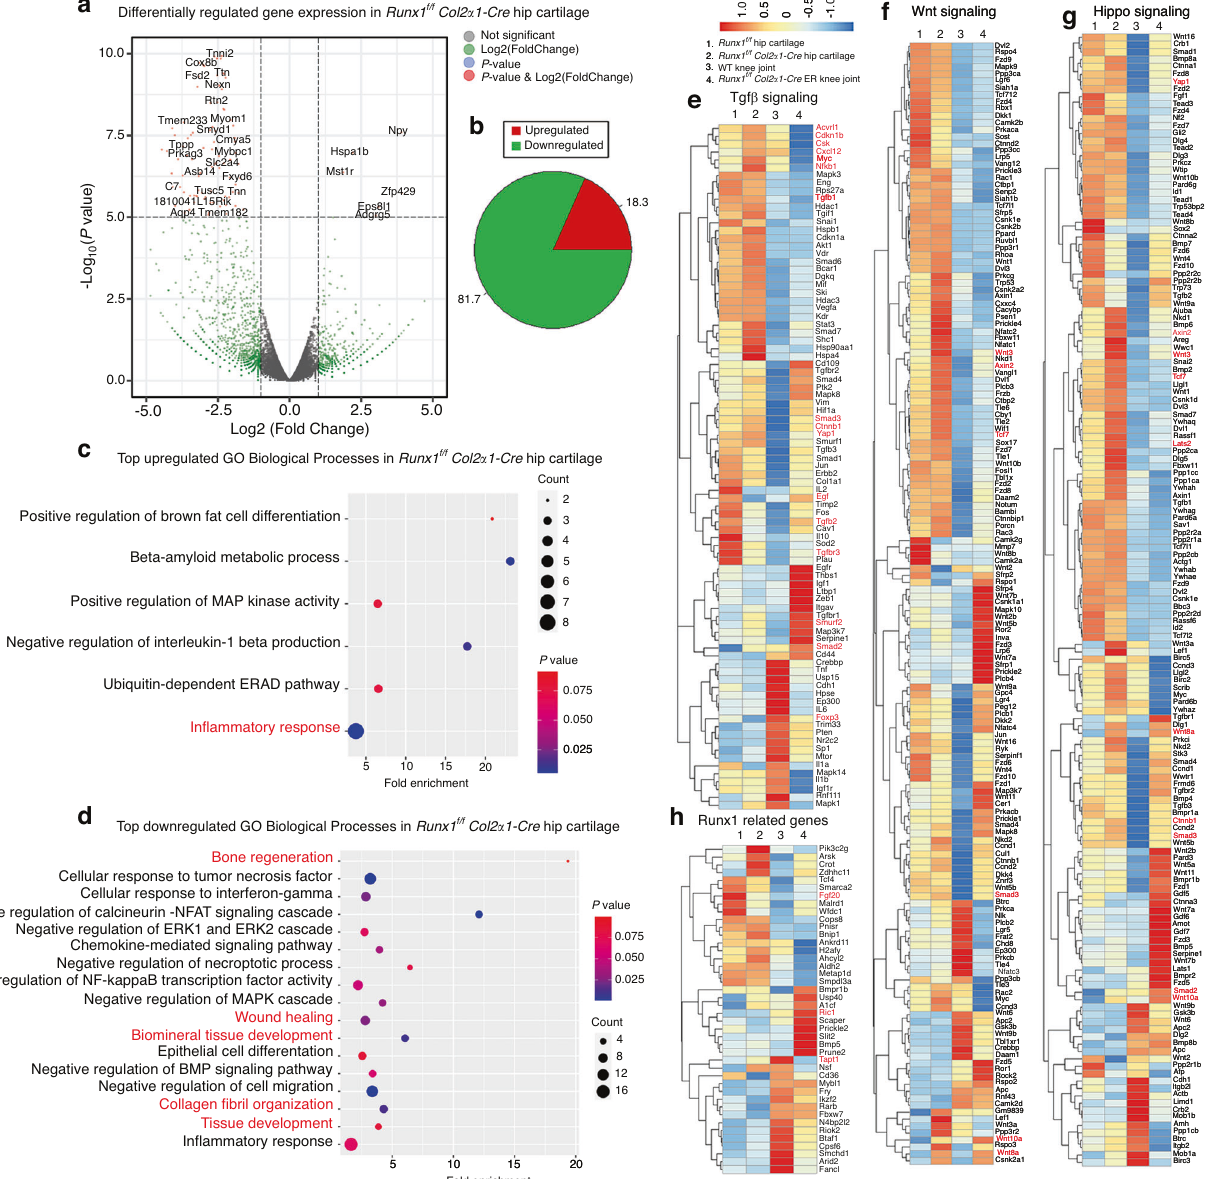
Fig. 4 RNA-sequencing analysis of Runx1-de fi cient hip and knee cartilage showed that Runx1 protected against cartilage loss in OA by regulating the TGF β , Wnt and Hippo signaling pathways. a Volcano plot illustrating differentially regulated gene expression from RNA-seq analysis between the control hip cartilage and cartilage from the Runx1 f/f Col2 α 1-Cre mice. b Pie chart of differentially regulated gene expression in hip cartilage. The percentages of genes upregulated and downregulated are shown in red and green, respectively. c Gene Ontology (GO) functional clustering of the top enhanced biological process (BP) in Runx1 f/f Col2 α 1-Cre mouse hip cartilage. d GO functional clustering of the top decreased BP in Runx1 f/f Col2 α 1-Cre mouse hip cartilage. e Heatmap for TGF β signaling-related gene expression in (1) hip cartilage of the Runx1 f/f mice, (2) hip cartilage of the Runx1 f/f Col2 α 1-Cre mice, (3) knee joint of the WT mice, and (4) knee joint of the Runx1 f/f Col2 α 1-Cre ER mice treated with TMX. f Heatmap for Wnt signaling-related gene expression. g Heatmap of Hippo signaling-related gene expression. h Heatmap for Runx1-related